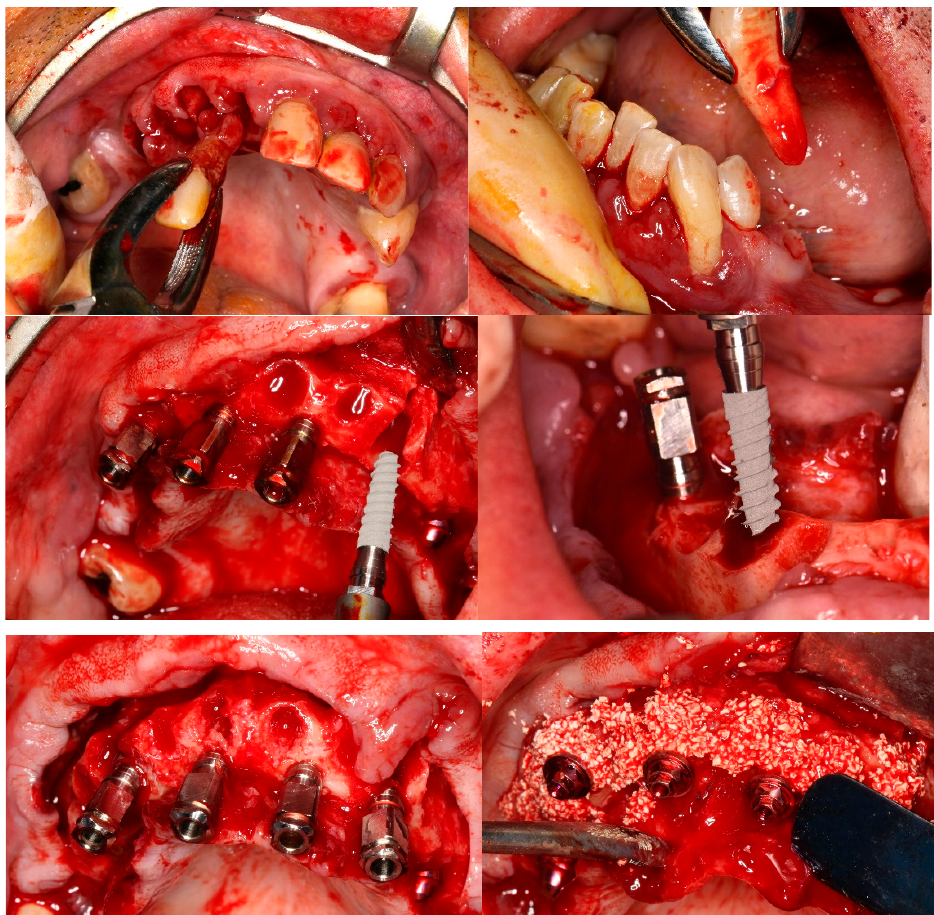
Figure 2. Clinical surgical protocol. Multiple tooth extraction, implant placement with mucosal flap approach, and the application of bone substitute.